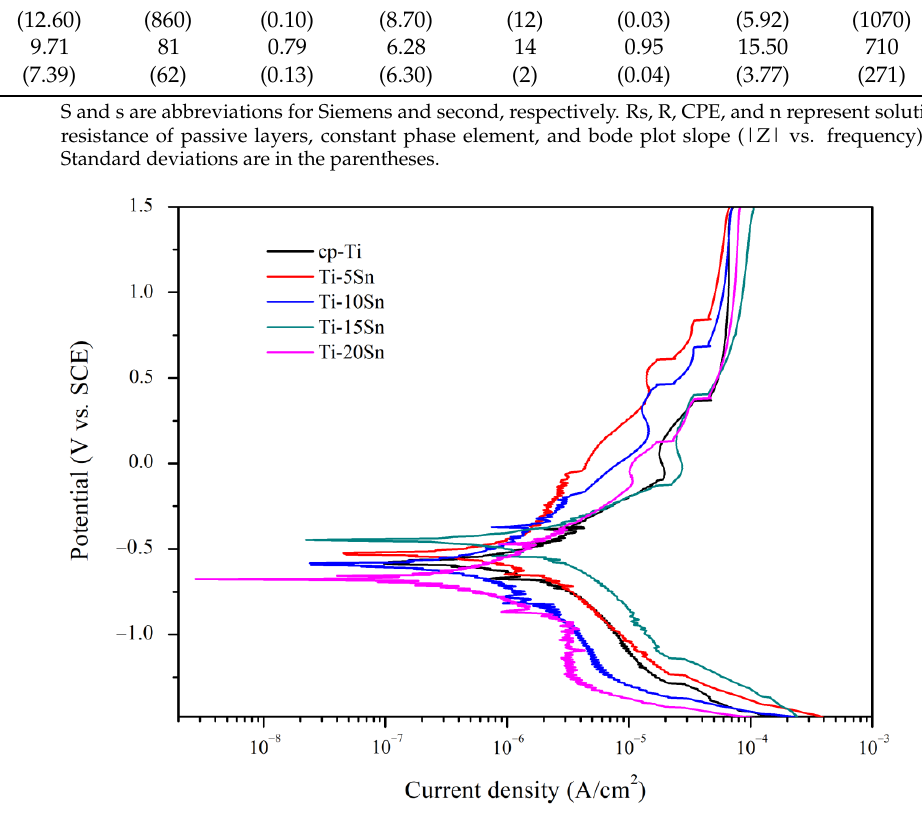
Figure 7. The potentiodynamic polarization curves of cp-Ti and Ti-Sn alloys in the range of − 1.5 V to 1.5 V vs. SCE in 0.9% NaCl solution at 37 ◦